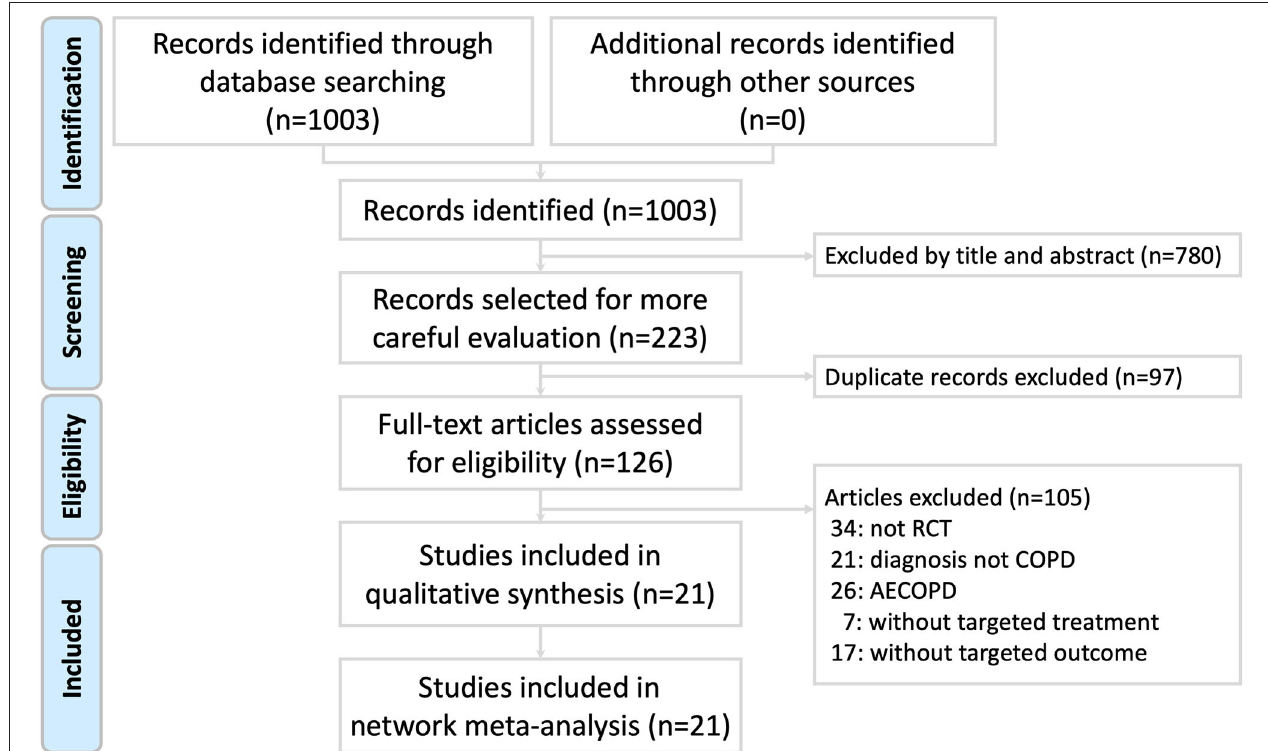
FIGURE 1 | Preferred reporting items for systematic reviews and meta-analysis (PRISMA) study flow